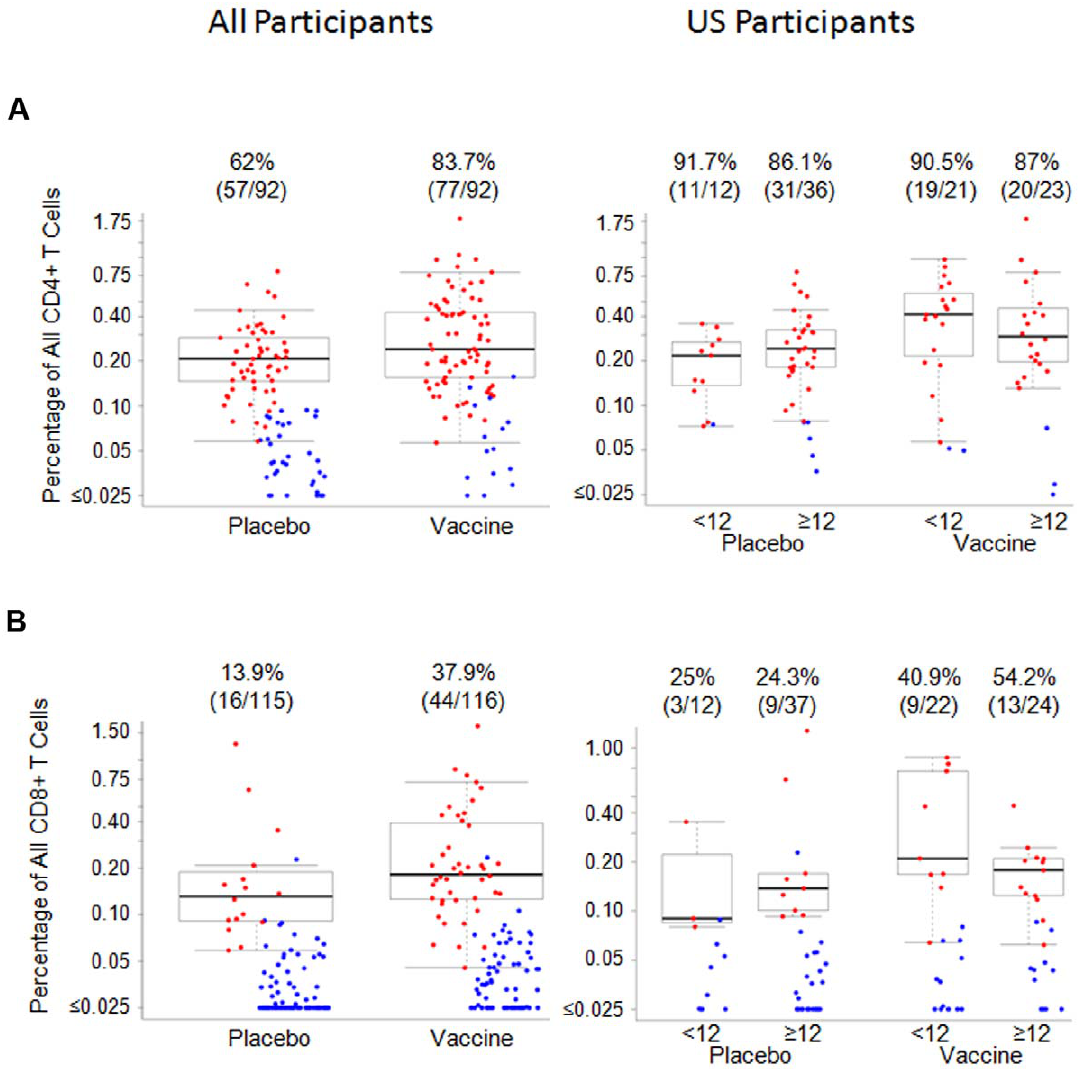
Figure 5. Magnitude of CD4 + and CD8 + T cell ICS responses to empty Ad5 vector. Percentage of CD4 + (top panels) and CD8 + T cells (bottom panels) producing interferon- c and/or interleukin 2, or both, by intracellular cytokine staining, in response to Ad5 empty vector stimulation in all (left panels) or US only (right panels) placebo and vaccine recipients 6 weeks after the Ad5 boost. Positive responders are shown in red and negative responders in blue. The box plots and numbers above the graphs are as in Figure